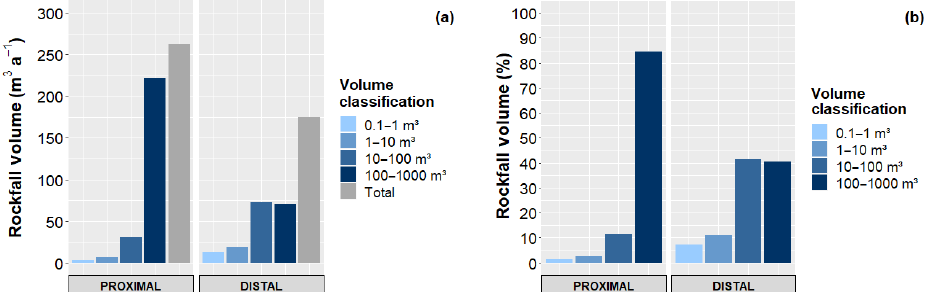
Figure 4. (a) Absolute rockfall volume (m 3 a − 1 ), (b) relative rockfall volume (%) for rockwall sections 0–10 vertical metres above the glacier surface (“proximal”) and for higher (>10m) rockwall sections (“distal”). Large events (100–1000m 3 ) dominate rockfall size distributions in proximal areas, while distal areas show a more balanced